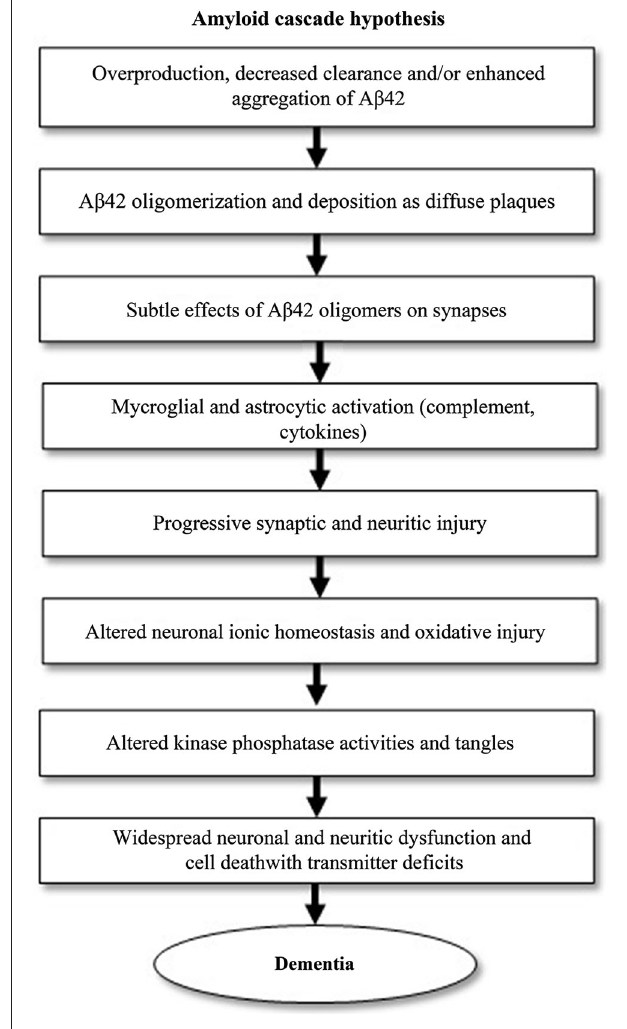
FIGURE 1 | The amyloid cascade hypothesis, adapted from Citron (2004). The pathogenic events shown can eventually lead to Alzheimer’s disease (AD). The cascade starts with the generation of amyloid- β 42 (A β